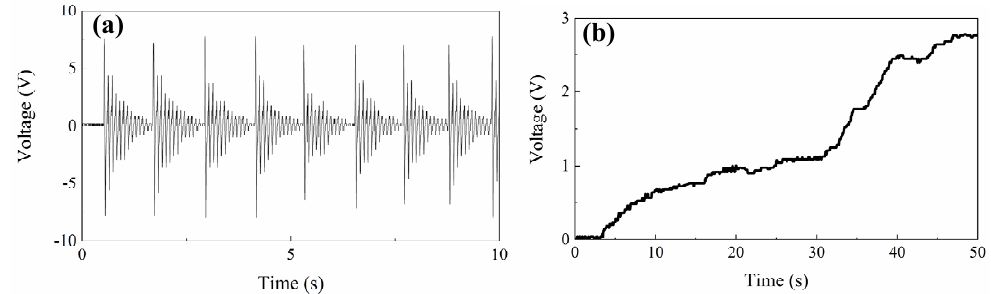
Figure 14. Applying proposed PVEH in harvesting stamping vibration. ( a ) Output voltage of pro- posed PVEH; ( b ) The voltage over charged capacitor.